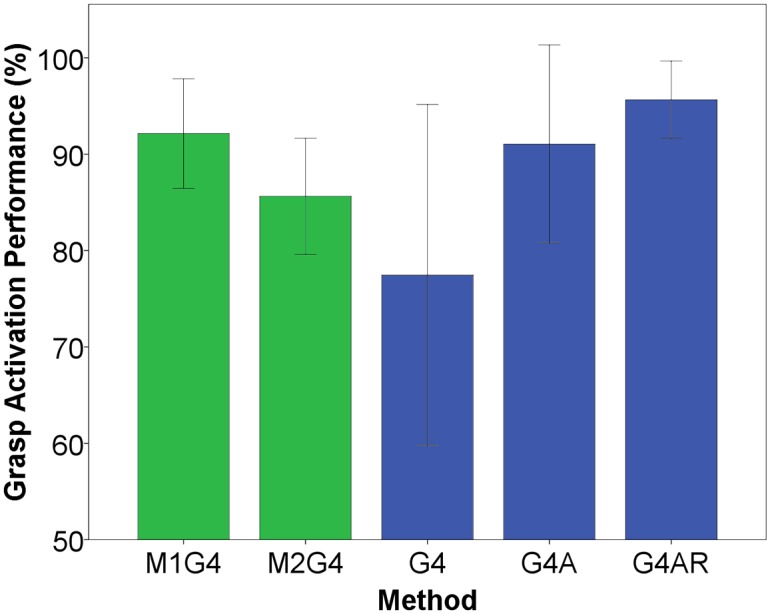
Grasp selection performance between the Menu interface modes (M1G4, M2G4) and the Myoelectric interface modes for 4 grasps (G4, G4A, G4AR).The error bars indicate the standard error.